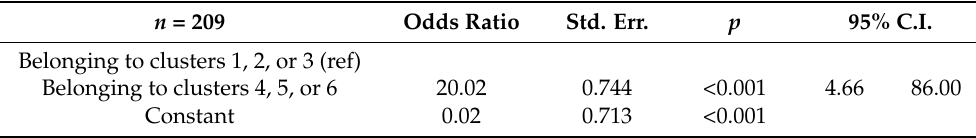
Table 3. Logistic regression model for the risk of